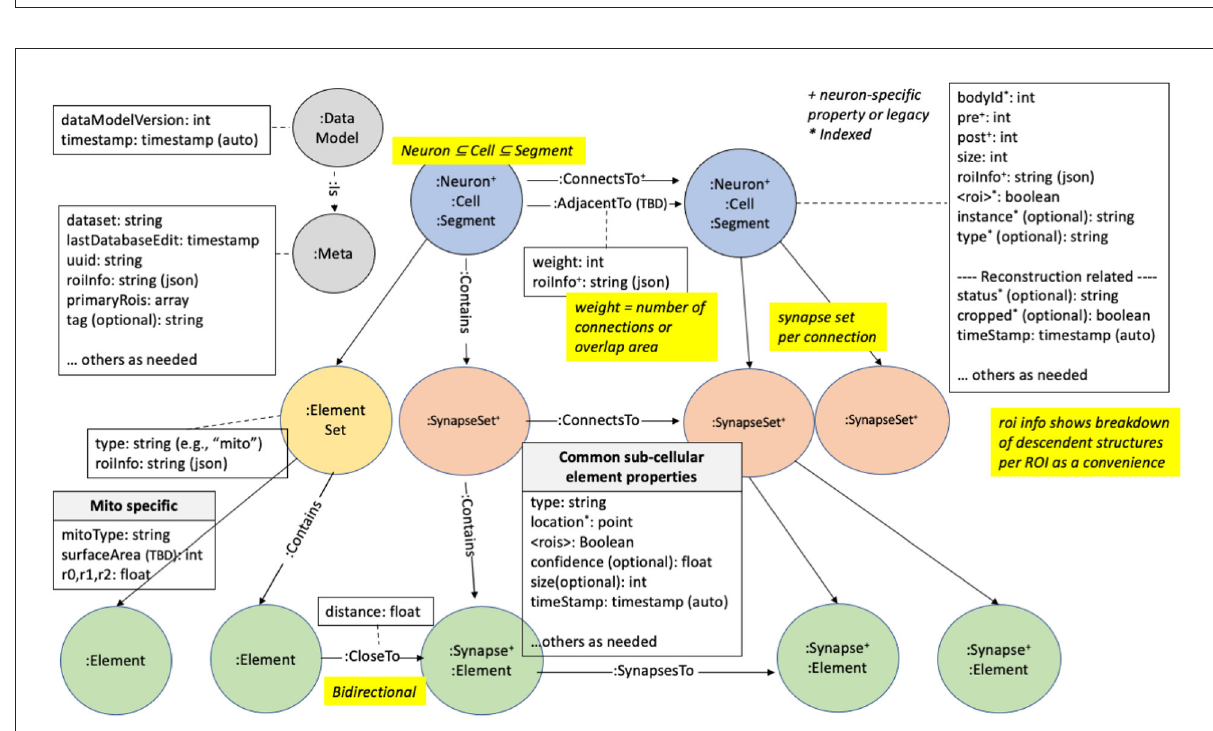
FIGURE2 neuPrint graph data model. This shows the various node types and properties used for storing data relevant for connectome analysis.